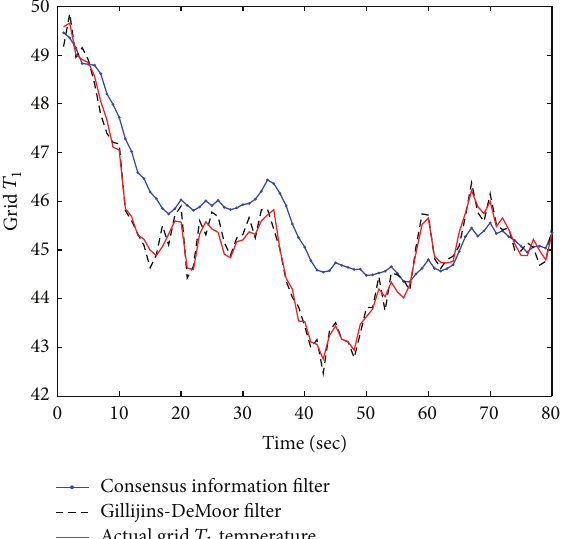
Figure 2: Temperature values of the leftmost grid.